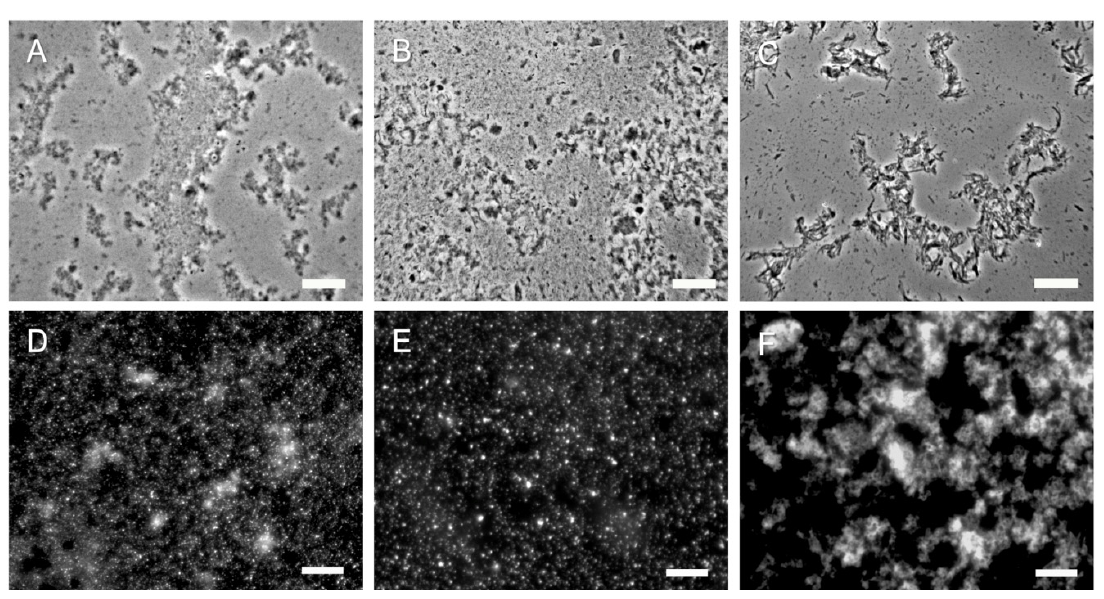
Figure 5. Representative microscopy images of SSCs and 2 k chitin from hyphae of three different fungi. ( A – C ) 2 k fractions from C. albicans , A. fumigatus and M. circinelloides , respectively (phase contrast); ( D – F ) SSCs from the corresponding fungi were stained with CFW and then viewed by fluorescence microscopy. Bars, 10 µm.